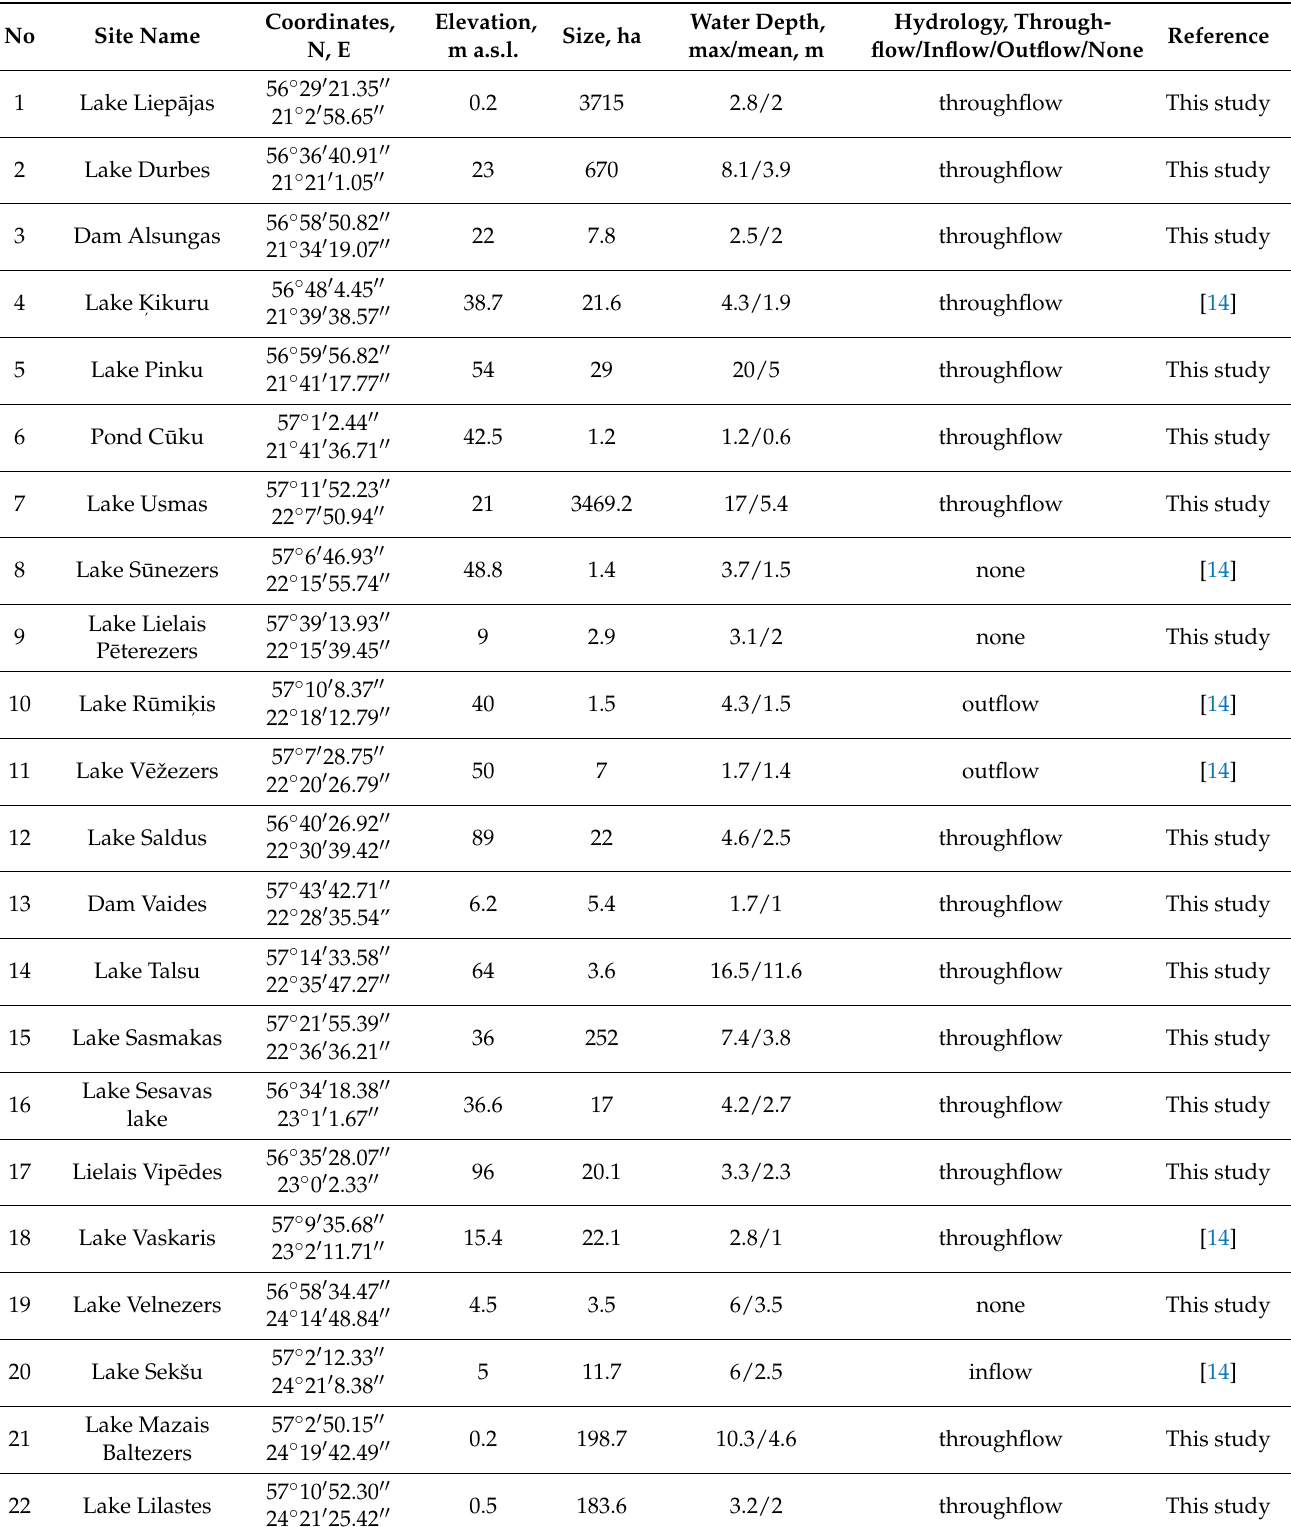
Table 1. Study sites and related